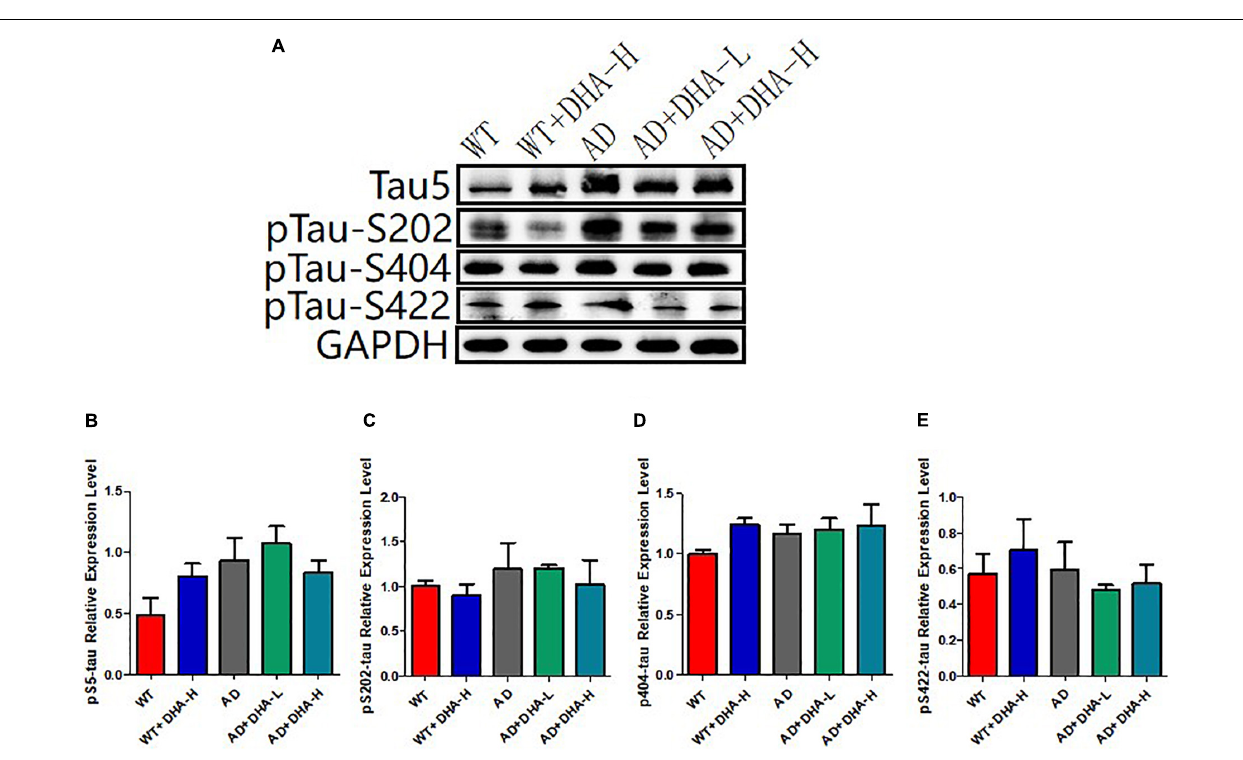
FIGURE 5 | Detection of expression levels of total tau and phosphorylated tau protein in mouse hippocampus ( n = 4). (A) Western blot detection of the expression levels of total tau and phosphorylated tau protein in the hippocampus of mouse brain; (B) Quantitative analysis of the gray value of total tau protein. (C) The expression level of phosphorylated protein at S202 of Tau. (D) Tau at the S202 site; the expression level of phosphorylated protein at S404; the expression level of phosphorylated protein at S422 of (E)